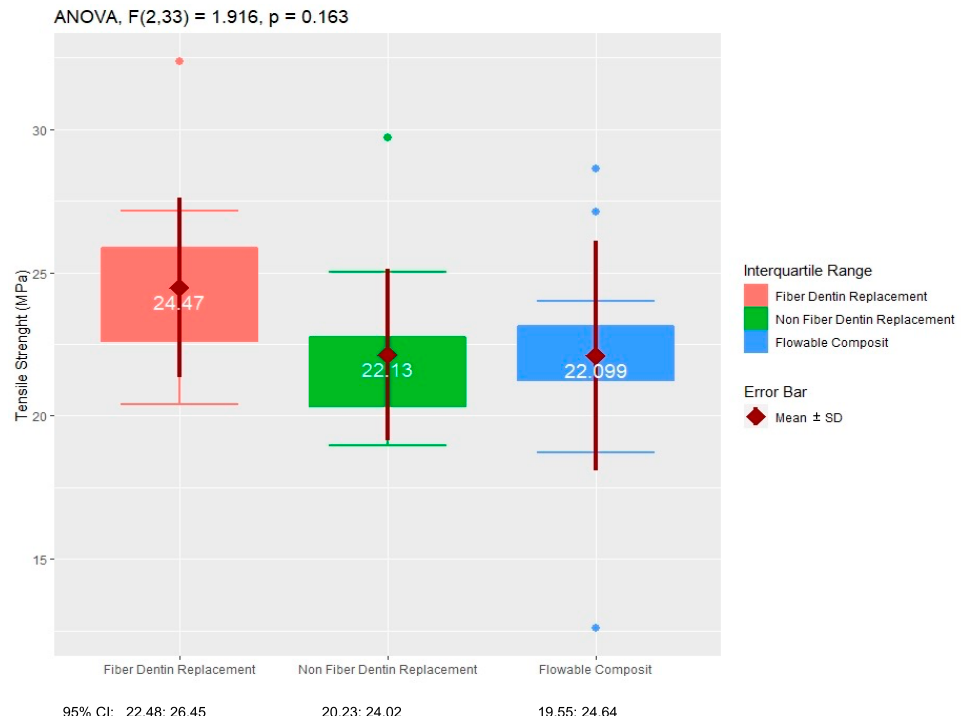
Figure 3. Box plot graphical representation of ANOVA result for tensile strength fiber dentin re- placement, non-fiber dentin replacement, and flowable composite.